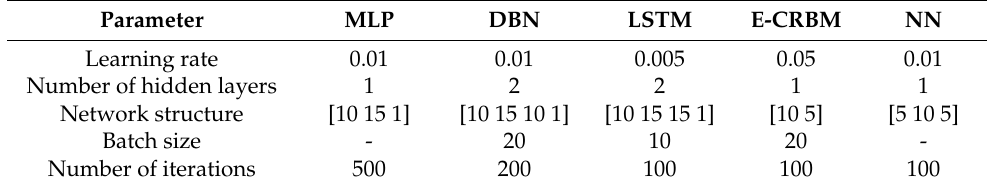
Table 3. Parameter settings of each